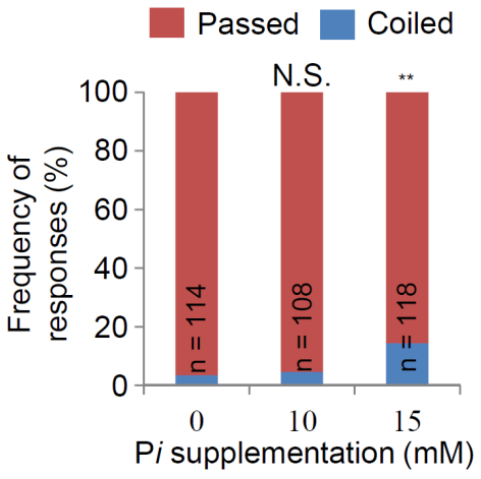
Figure 3. Increase in the nutritropic response of the main root (passed or coiled) of WRC 25 to NH 4+ in the P i -supplemented culture medium. Frequencies of the passed and coiled responses were determined in the nutritropic bioassay with a 200 mM NH 4+ nutrient source. Data of 0 mM P i were the same as those in Figure 2. The statistical significance was tested using Fisher’s exact test. N.S., not significant; **, p <